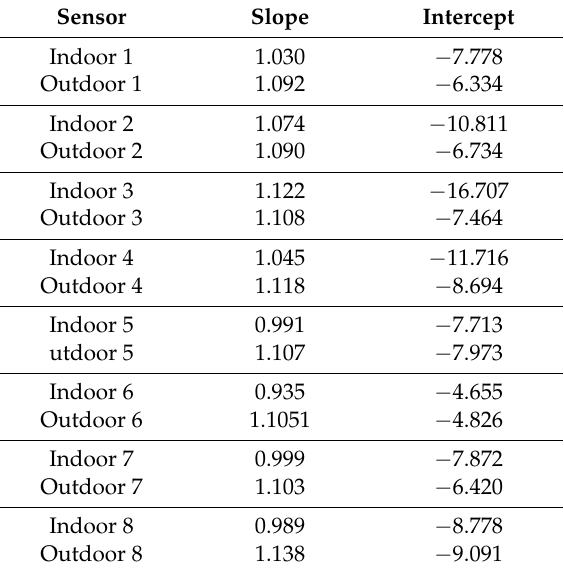
Table 2. The linear correction curve for the eight weather stations